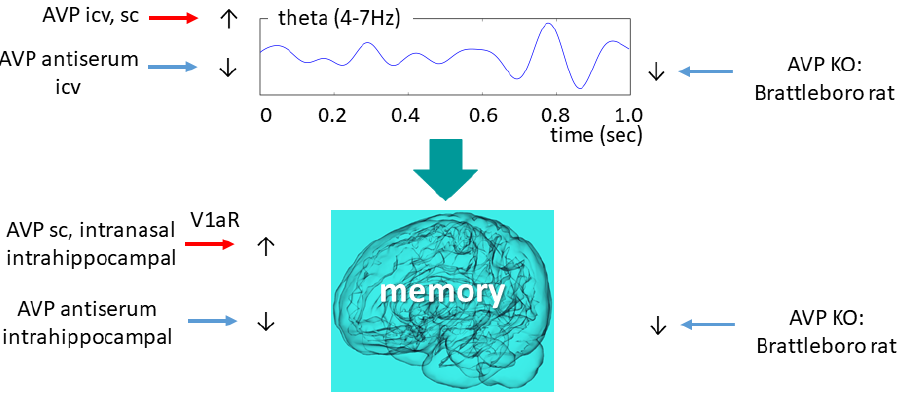
Figure 4. Vasopressinergic influence on theta oscillation and memory formation. Similar intervention induces similar changes in both highly connected measures. AVP—arginine vasopressin; ic—intracerebroventricular; KO—knockout; V1aR—vasopressin 1a type receptor.